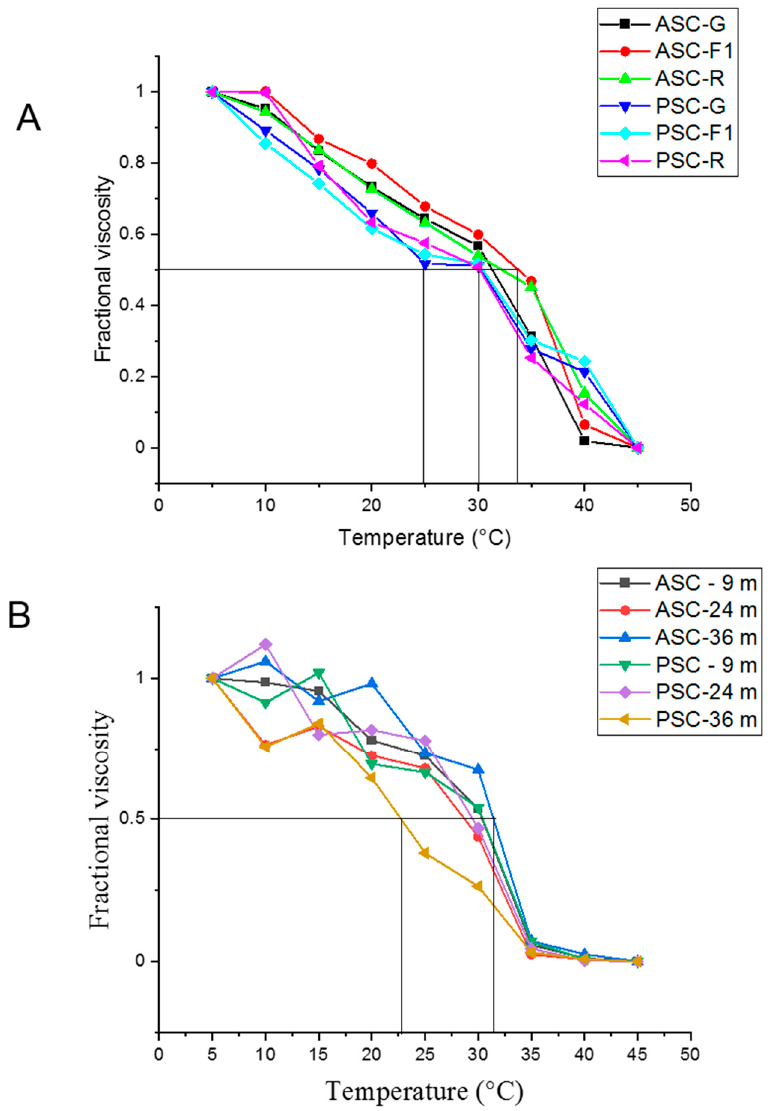
Figure 3. Thermal denaturation curves of tilapia skin collagen. ( A ). Collagen ASC and PSC of red, gray, and F1 strains (9-months old); ( B ). ASC and PSC collagens from F1 progeny ages 9, 24, and 36 months.